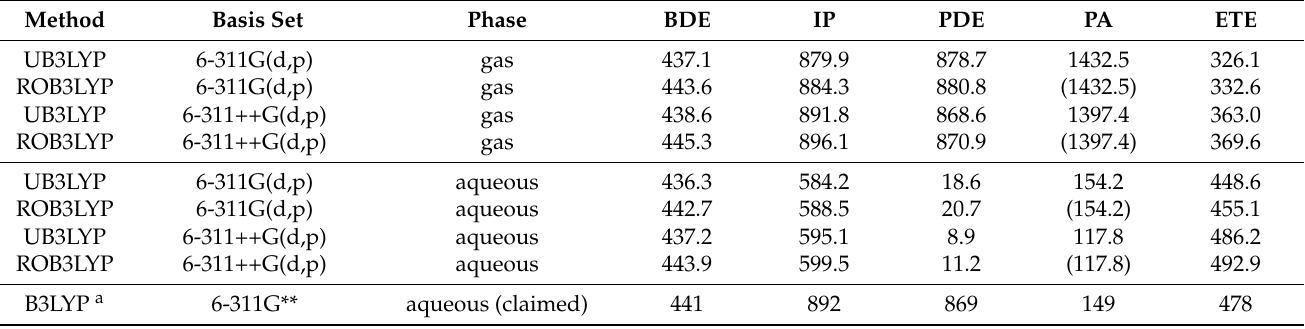
Table 9. The enthalpies of reaction (in kJ/mol) that quantify the antioxidant activity of vitamin B3 computed for gaseous and aqueous phases using the methods indicated. Notice that there is no difference between unrestricted (UB3LYP) and restricted open-shell (ROB3LYP) methods in calculating the PA values, and for this reason the the latter are written in parentheses. Values claimed to be for the aqueous phase of [23] are also included, but some thereof seem rather to be for gas.